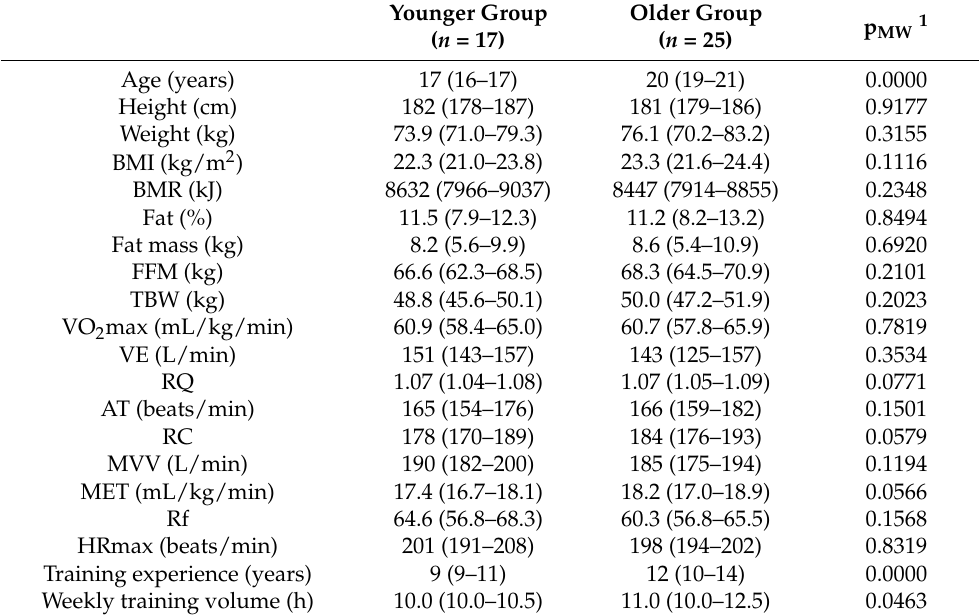
Table 3. The characteristic of the participants.